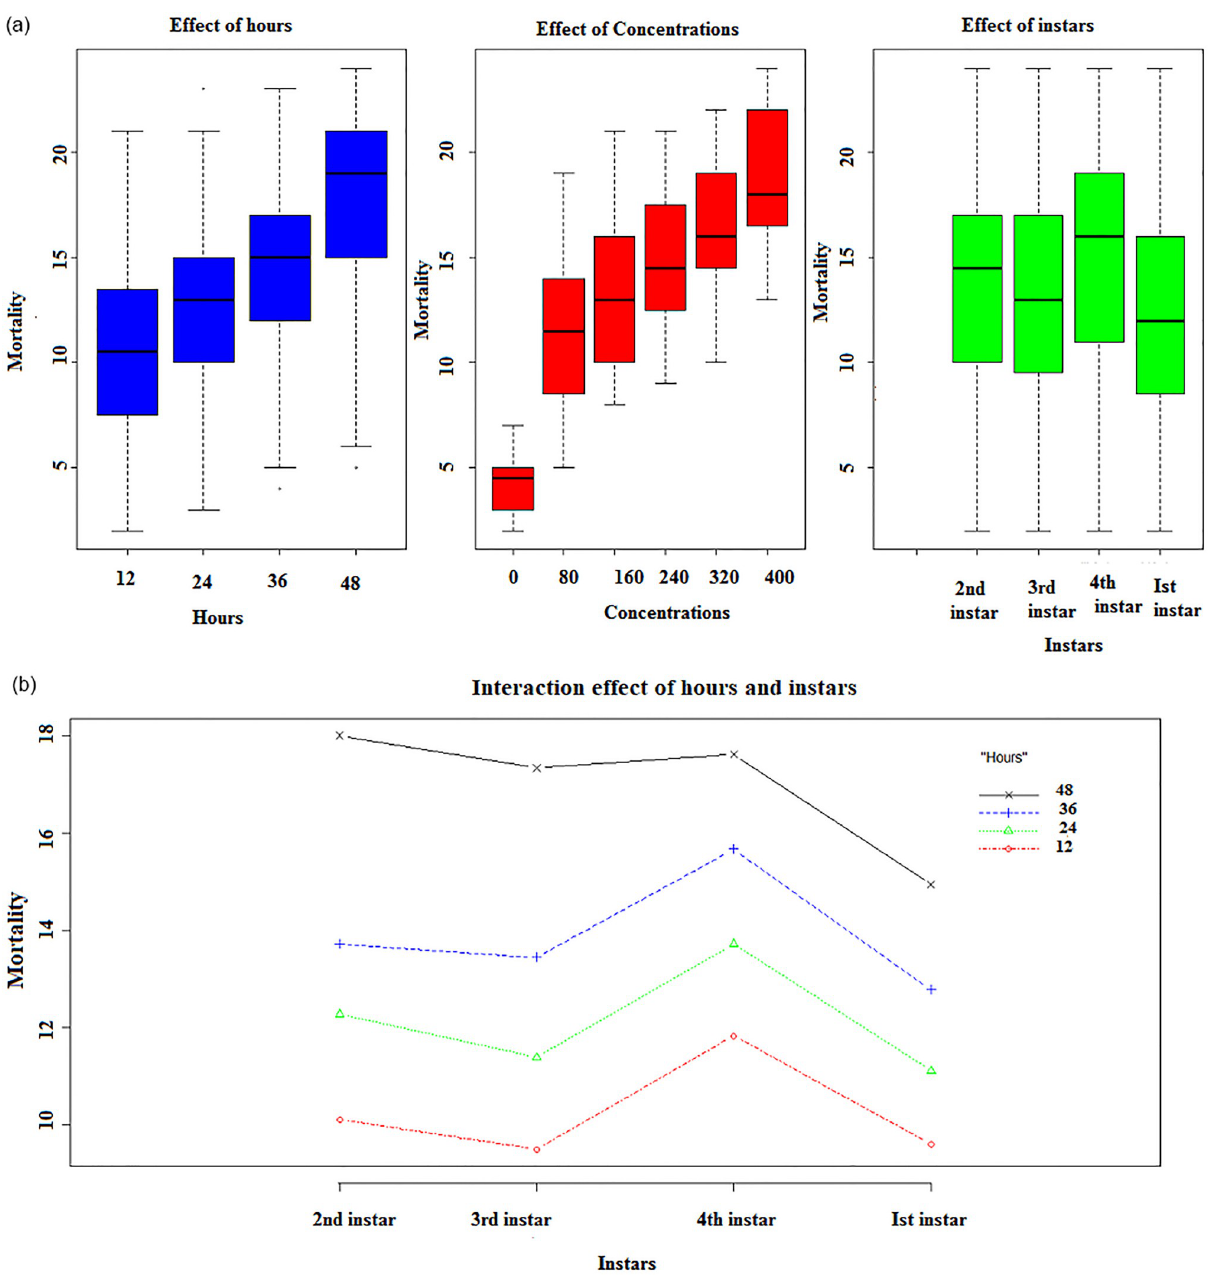
Fig 1. (a) Box plot representing the effect of hours, concentrations, and plant on the mean mortality of I st , 2 nd , 3 rd , and 4 th instars larvae in ethanol solvent. (b) Interaction plot representing the interacting effect of hours with instars on the mean mortality of I st , 2 nd , 3 rd , and 4 th instars larvae in ethanol